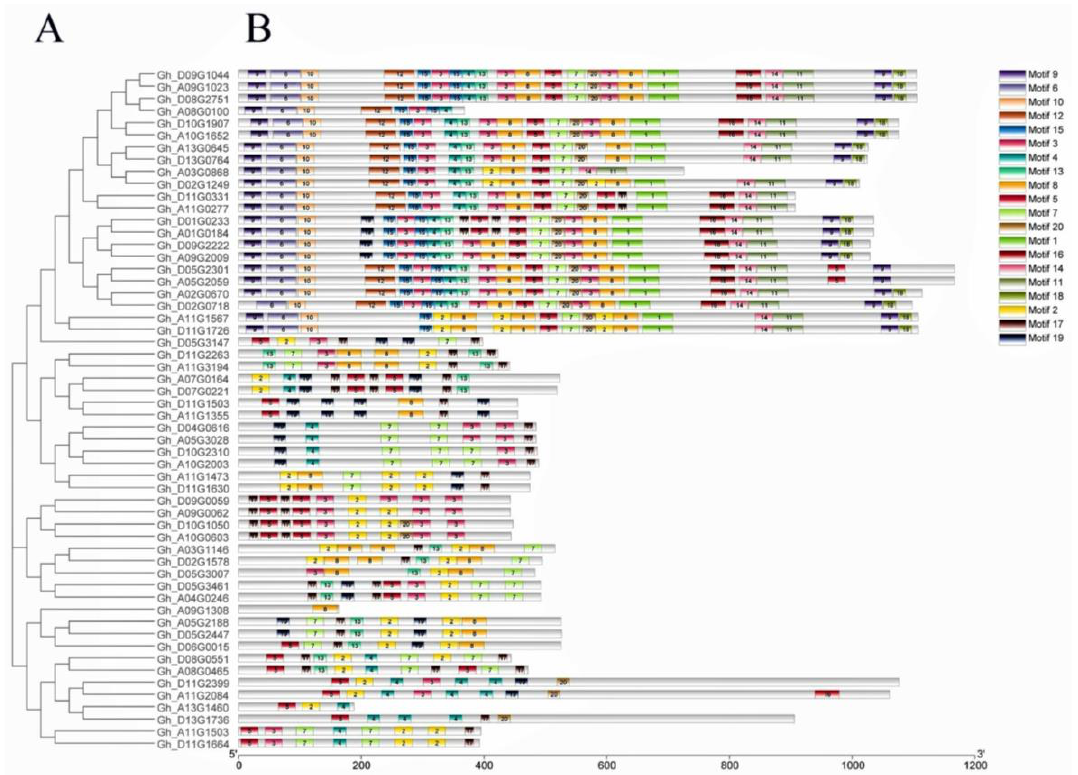
Figure 3. Phylogenetic and conservative motifs analysis of the RCC1 gene family in G. hirsutum . ( A ) The phylogenetic tree of all RCC1 genes in G. hirsutum was constructed using the adjacency method and the bootstrap test was performed with 1000 iterations. ( B ) The conserved protein motifs in the RCC1 family were identified using the MEME program. Each motif is represented by a different color.